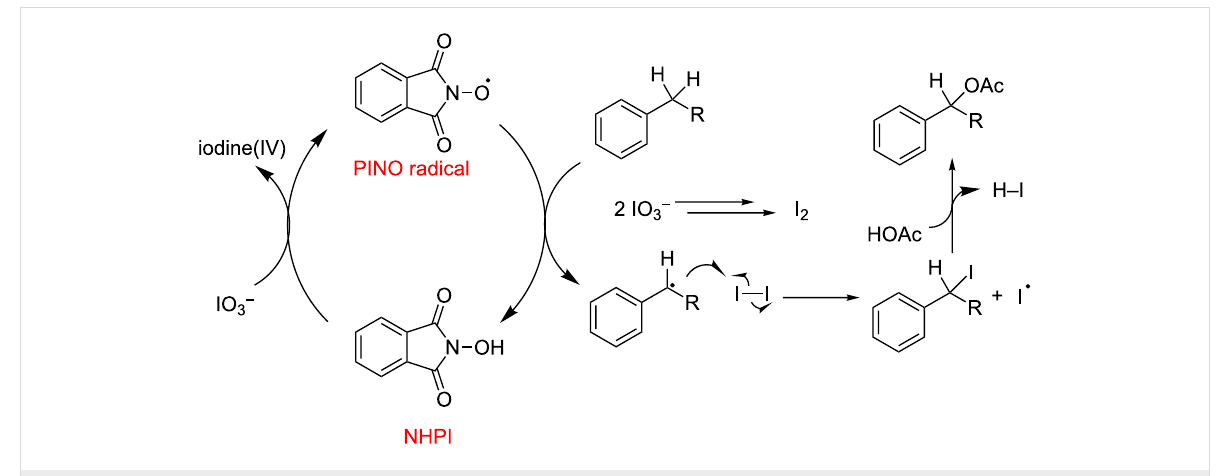
Figure 7: Proposed mechanism for the selective monooxygenation of benzylic C–H bonds.